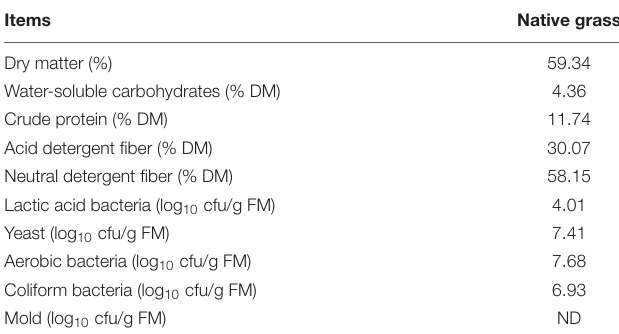
Chemical composition and microbial population of native grass prior to ensiling.